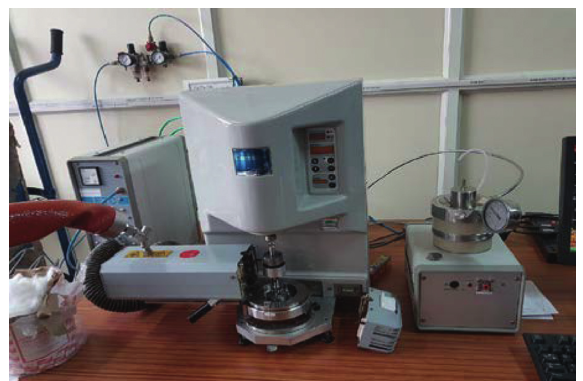
Figure 14: Air bearing rheometer.